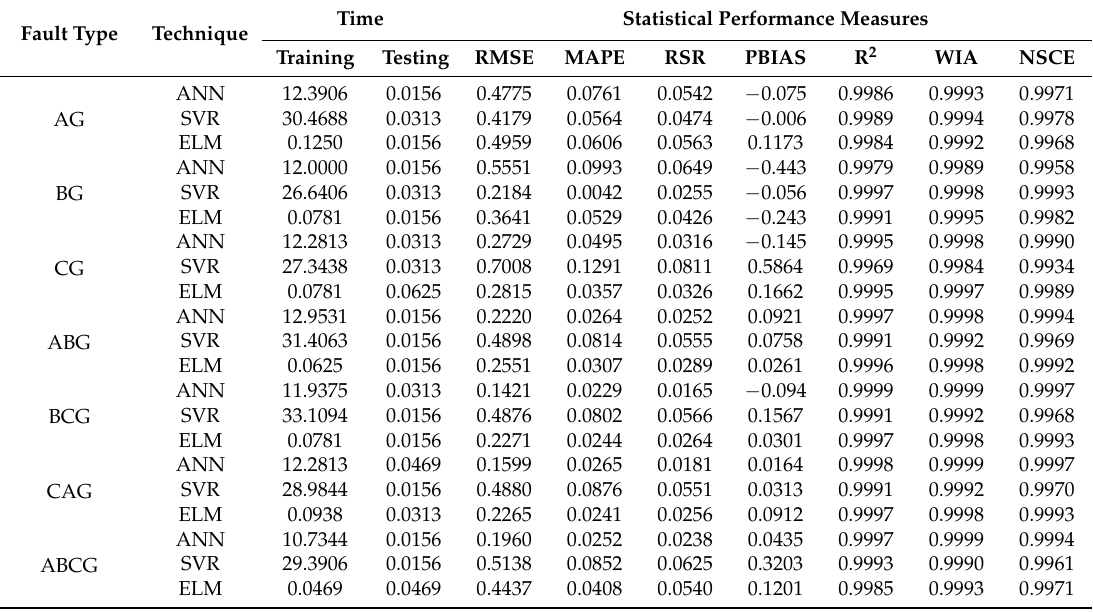
Table 7. Operation time and the statistical performance indices, for the test datasets with CF-PSO optimized MLT, in the presence of 30 dB SNR.